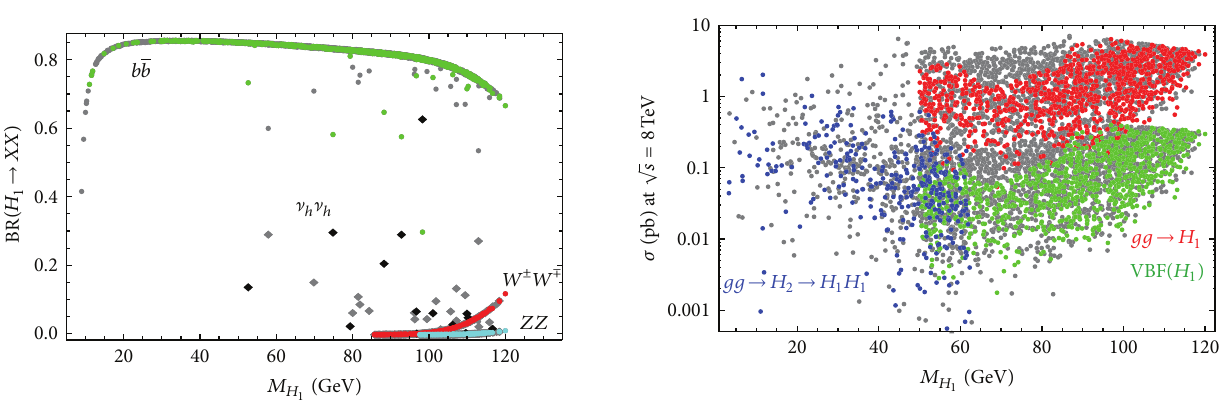
Figure 9: Cross sections at √𝑠 = 8TeV for different production mechanisms. Gluon-fusion (in red) and vector-boson-fusion (in green) mechanisms are displayed only for 𝑀 𝐻 simplicity. Gray points are excluded by the low energy observables and by HiggsBounds